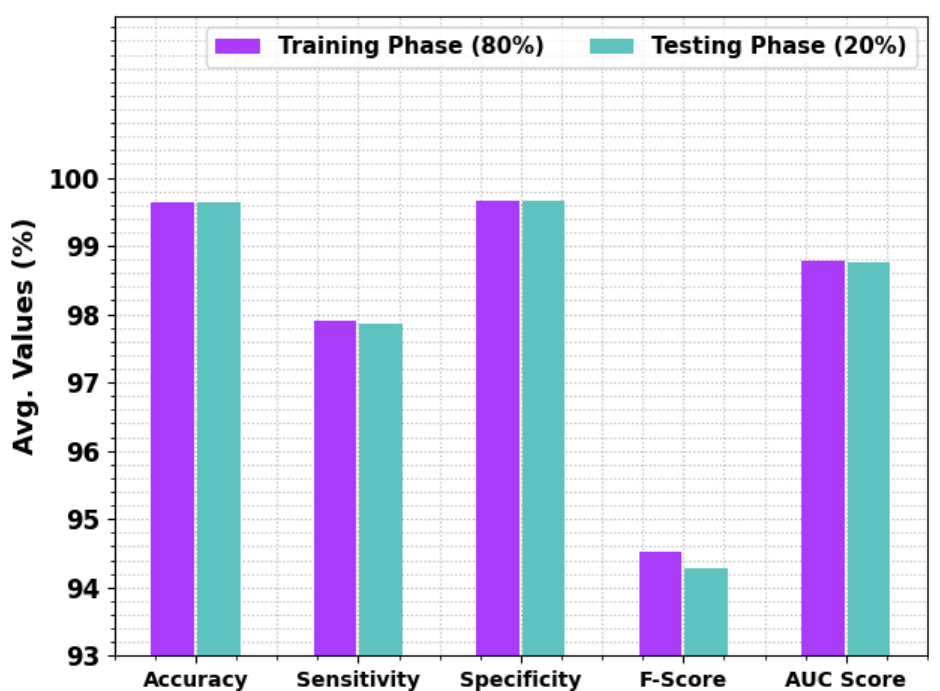
Figure 4. The average outcome of the BCOA-MLID approach on TRP/TSP of 80:20.